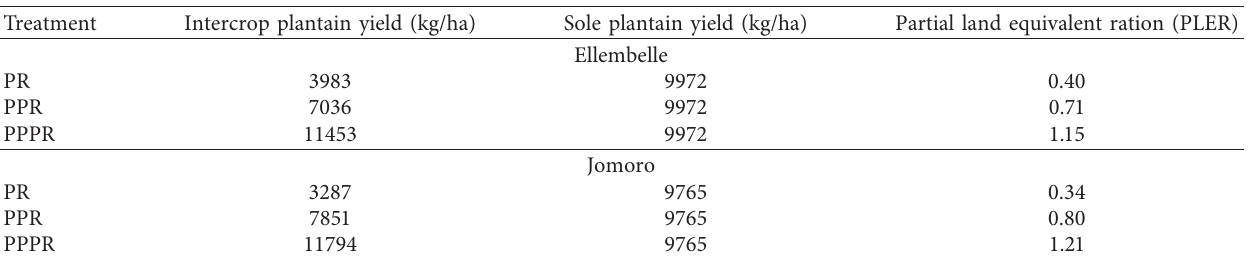
Table 12: Partial land equivalent ratios of plantain in rubber-plantain intercropping systems at Ellembelle and Jomoro. Treatment Intercrop plantain yield (kg/ha) Sole plantain yield (kg/ha) Partial land equivalent ration (PLER)